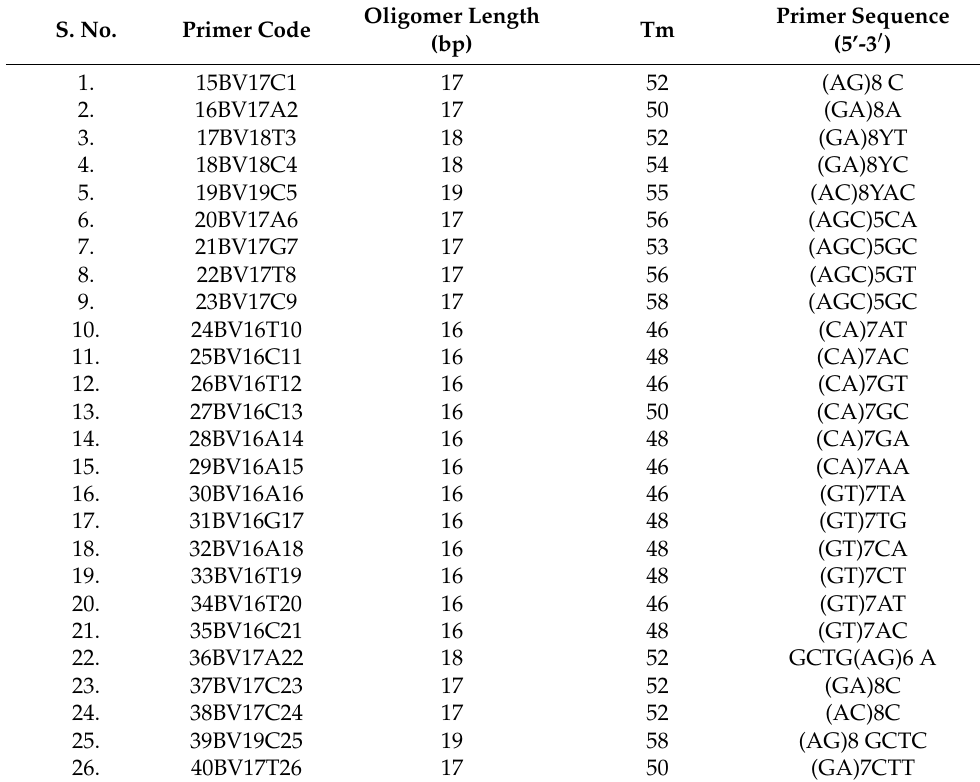
Table 2. ISSR primers with their sequence and calculated